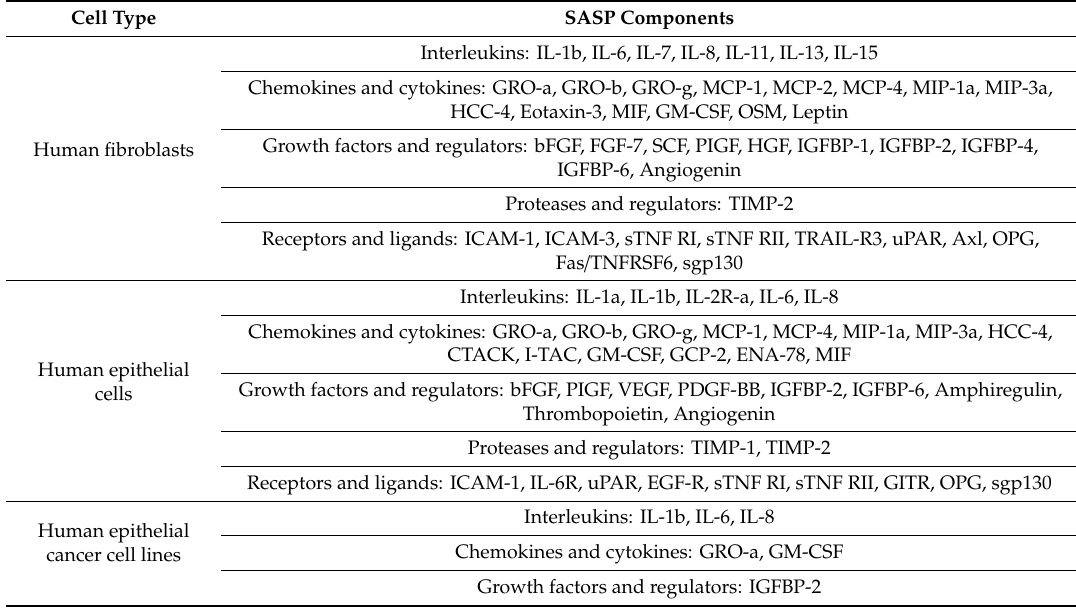
Table 1. Major SASP components in di ff erent senescent cell